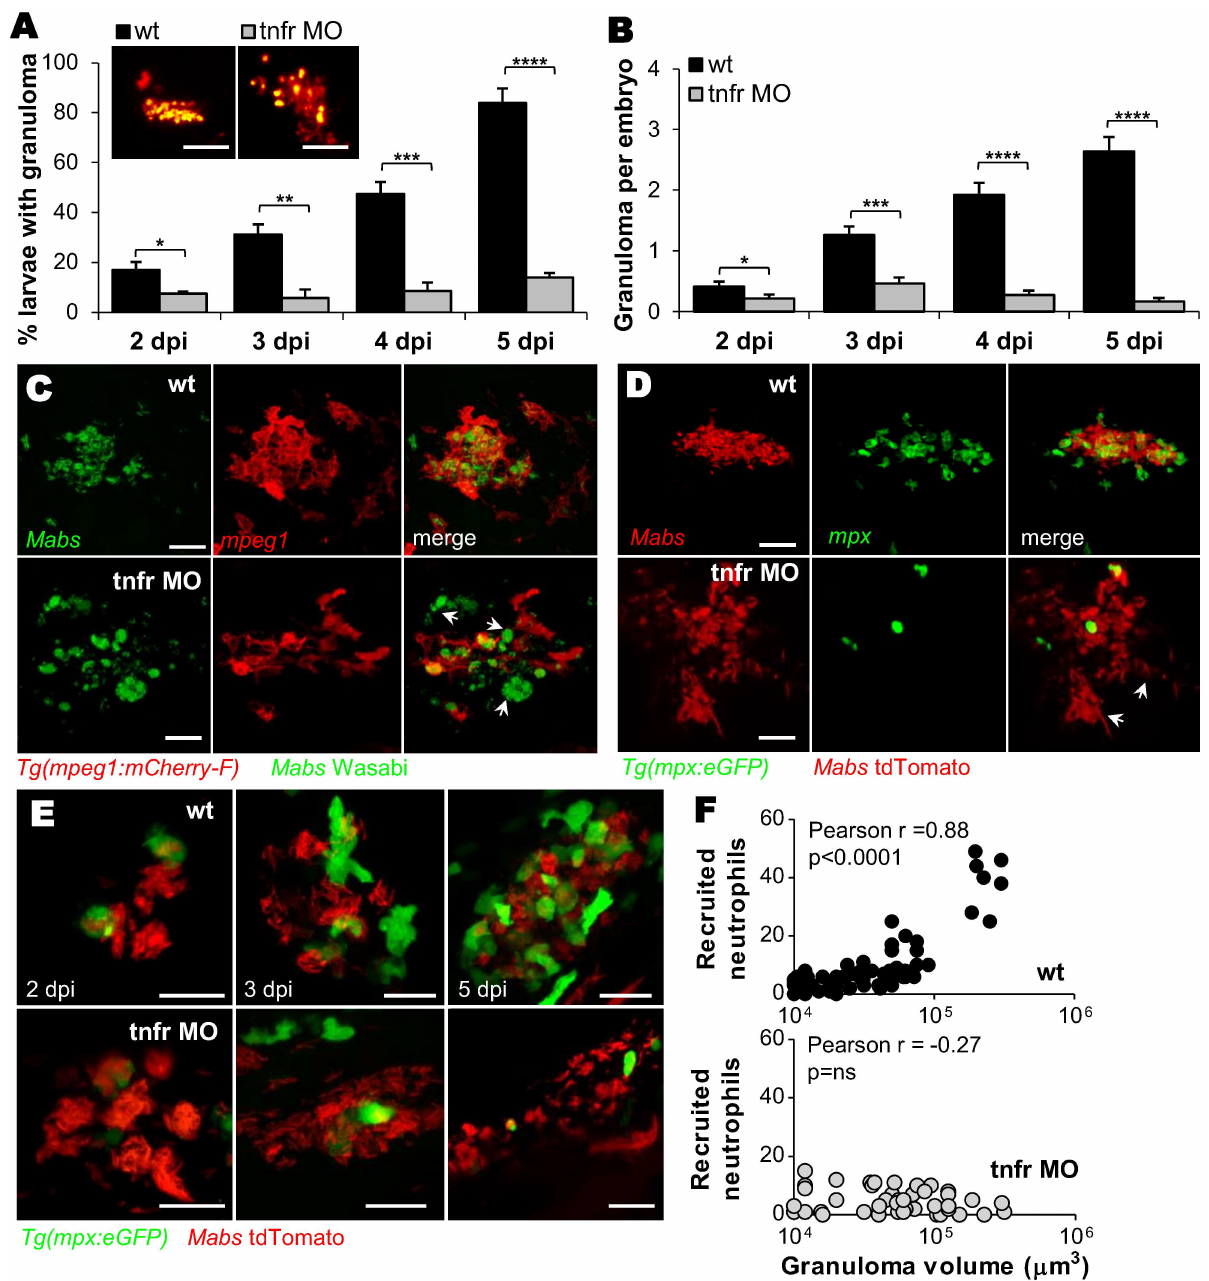
Fig 7. Recruitment of neutrophils is crucial for granuloma development. (A and B) WT or tnfr morphants were iv infected with R Mabs (tdTomato, (cid:25) 150 CFU). Kinetics of granuloma formation (A) and mean ± SEM number of granuloma per infected embryos (B) in (A); (n = 30–45, three independent experiments). The top panel shows confocal images of representative granuloma. Scale bars, 100 μ m. (C) Confocalimages showinga representative 3 dpi granulomas in WT versus tnfr1 morphant Tg(mpeg : mcherry-F) embryos iv infected with S expressing Wasabi. Arrows indicate extracellular aggregates.Scale bars, 15 μ m. (D) Confocal microscopy showingrepresentative granulomas in WT and tnfr1 morphant Tg(mpx : eGFP) embryos iv infected with R expressing tdTomato at 4 dpi. Arrows indicate extracellular cords. Scale bars, 30 μ m. (E-F) Confocal microscopy monitored WT or tnfr morphant Tg(mpx : eGFP) embryos that were iv infected with R (tdTomato, (cid:25) 150 CFU). (E) Representative kinetics of neutrophil mobilization during granuloma formation. Scale bars, 20 μ m. (F) Number of neutrophils recruited to WT (up) or TNFR1-depleted (down) granuloma as a function of granulomavolume. Statistical significance was determinedby Fisher’s exact test of a contingency table (A), one-tailedunpairedStudent’s t test (B) or Pearson correlation(F). See also S6 and S7